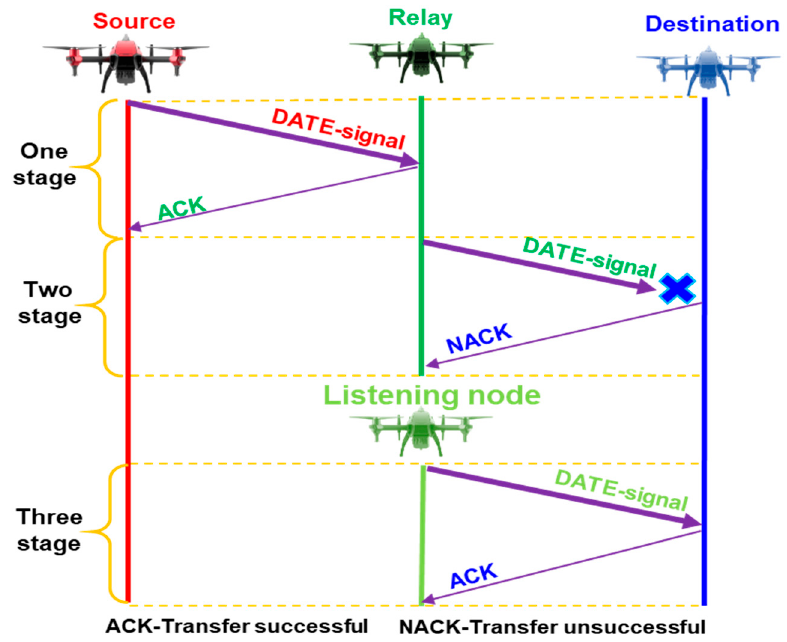
Figure 2. Diagram of the retransmission request control policy based on listening nodes.